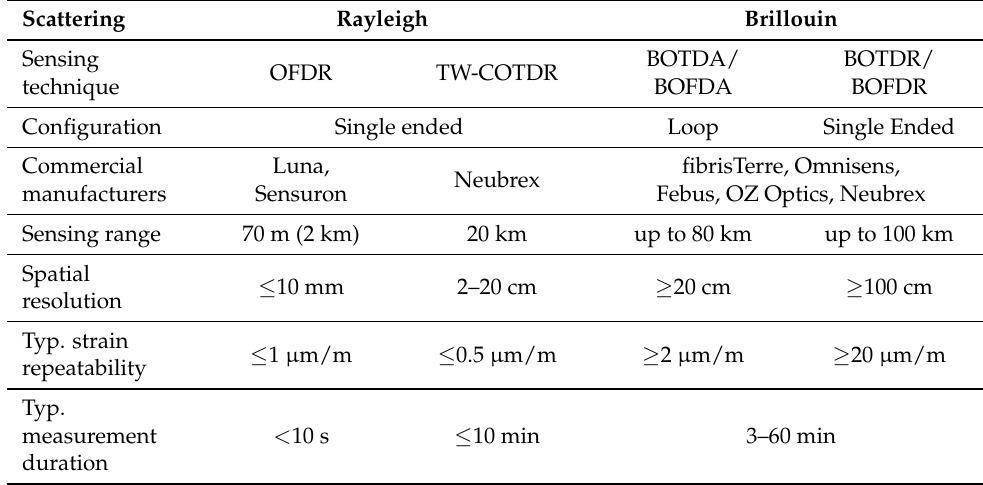
Table 1. Characteristics of different distributed fiber optic strain sensing systems (specifications obtained from corresponding product datasheets [31–39] and laboratory tests, see, e.g., in